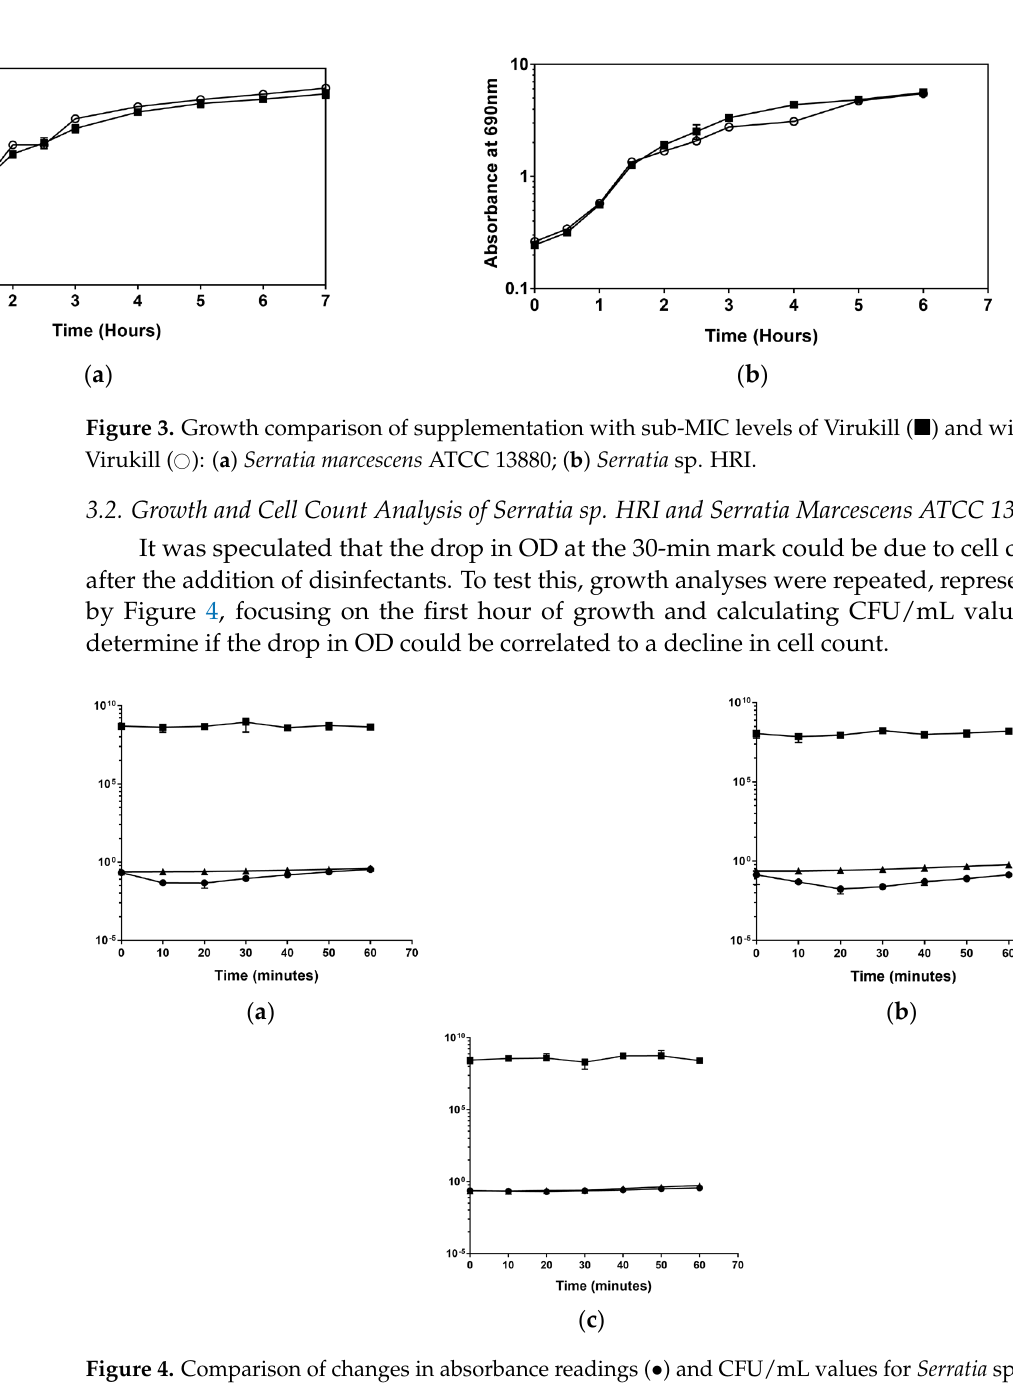
Figure 4. Comparison of changes in absorbance readings (●) and CFU /mL values for Serratia sp. HRI ( ■ ) as well as CFU/mL values of Serratia marcescens ATCC 13800 ( ▲ ) over 60 min cultivated in the presence of sub-MIC levels of disinfectants: ( a ) Benzalkonium chloride; ( b ) DDAC; ( c ) Virukill.